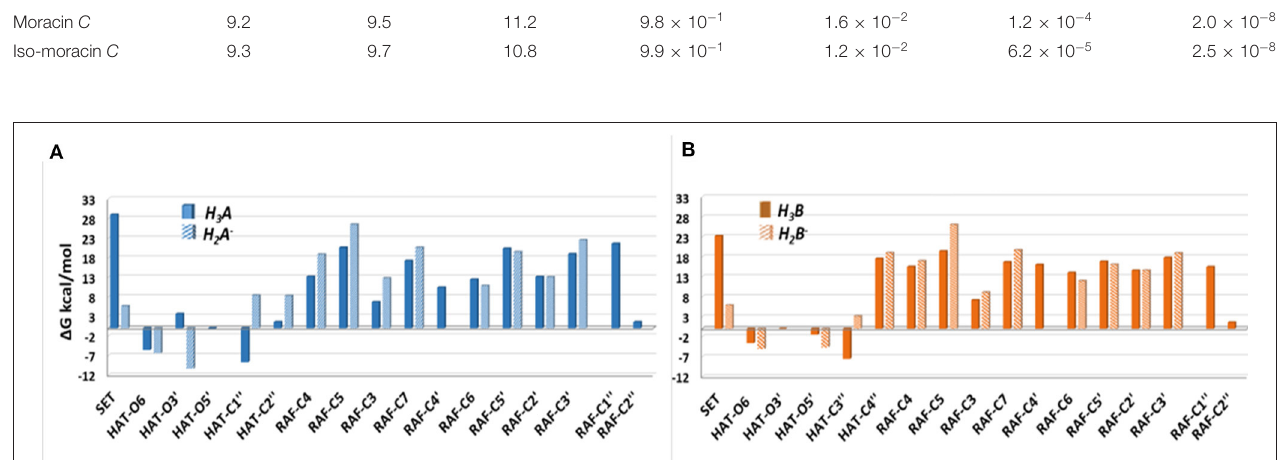
TABLE 1 | pKa value and molar fractions (Mf) of the different acid–base species of moracin C and iso -moracin C, at physiological pH. Molecule pKa 1 pKa 2 Moracin C